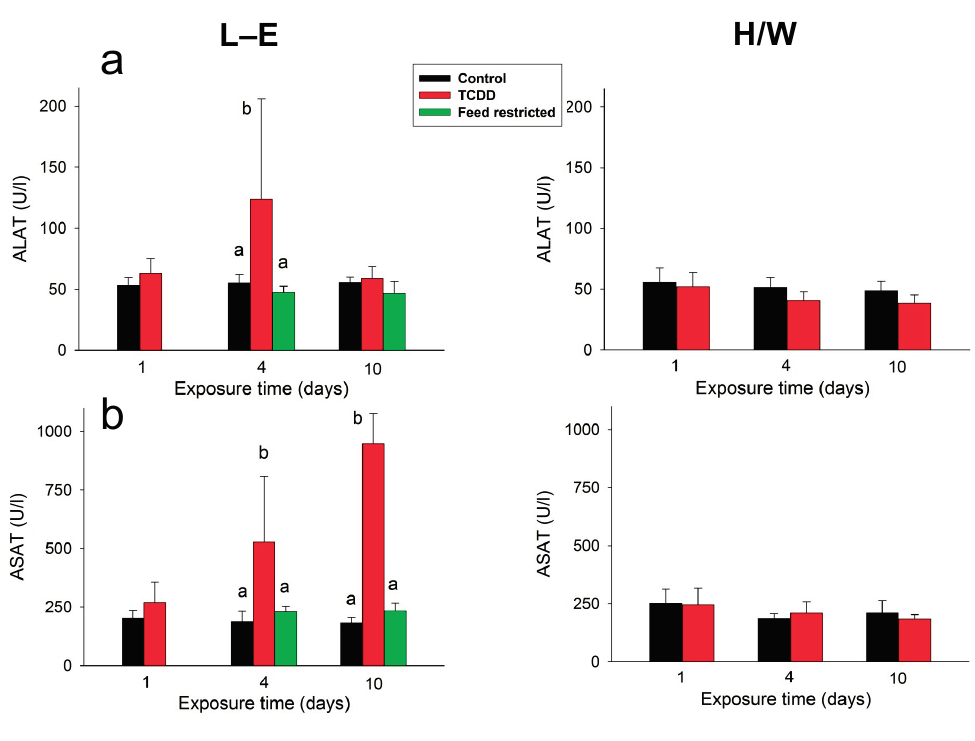
Figure 8. The effect of TCDD or feed restriction on ( a ) serum ALAT and ( b ) ASAT concentrations in L-E ( left panel) and H/W rats ( right panel) as a function of time (mean ± SD). The conditions are as in Figure